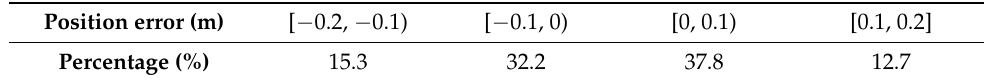
Table 3. Position error distribution